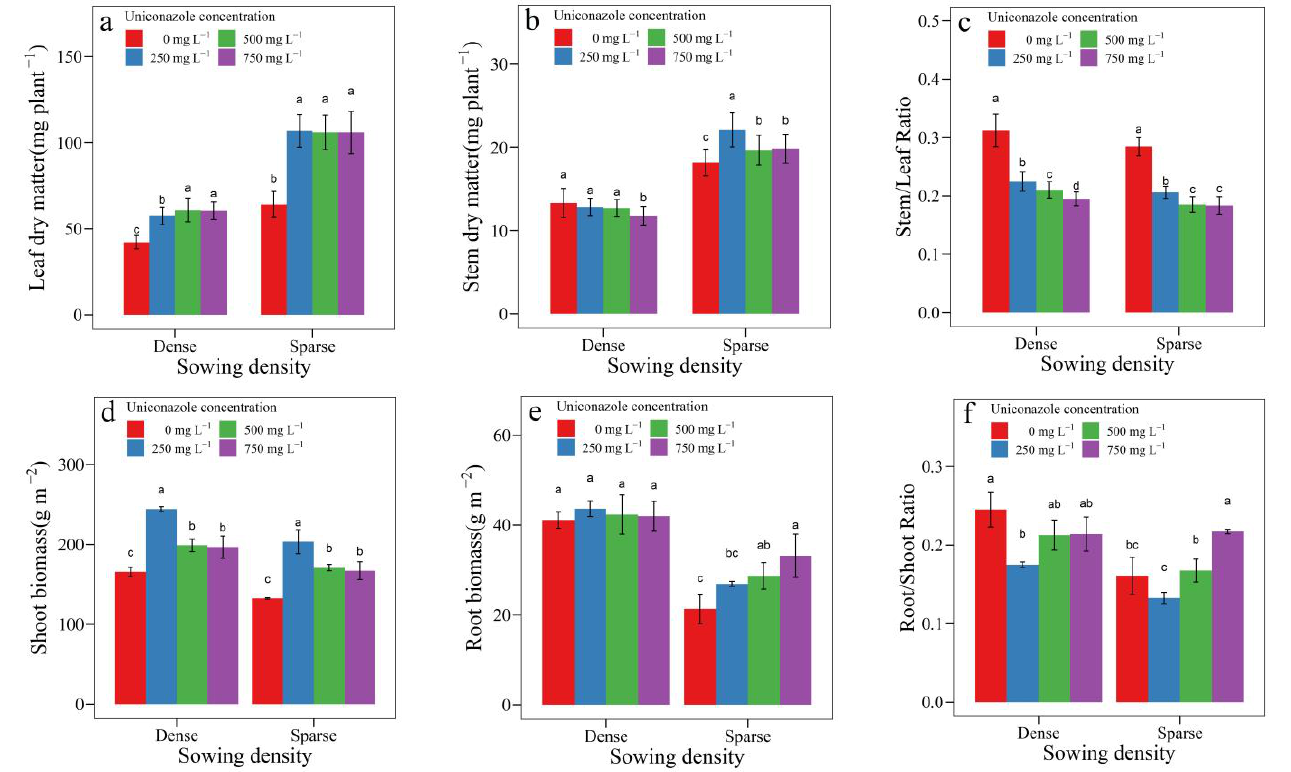
Figure 3. The effect of uniconazole on seedling dry matter, biomass, and allocation in two sowing densities. Values are the seedling dry matter and biomass measured at 30 d of leaf dry matter ( a ), stem dry matter ( b ), stem/leaf ratio ( c ), shoot biomass ( d ), root biomass ( e ), and root/shoot ratio ( f ). Sparse and dense represent sowing densities of 400 and 800 seeds per tray, respectively. Significant effects ( p ≤ 0.05) are shown by different letters in the same sowing density.